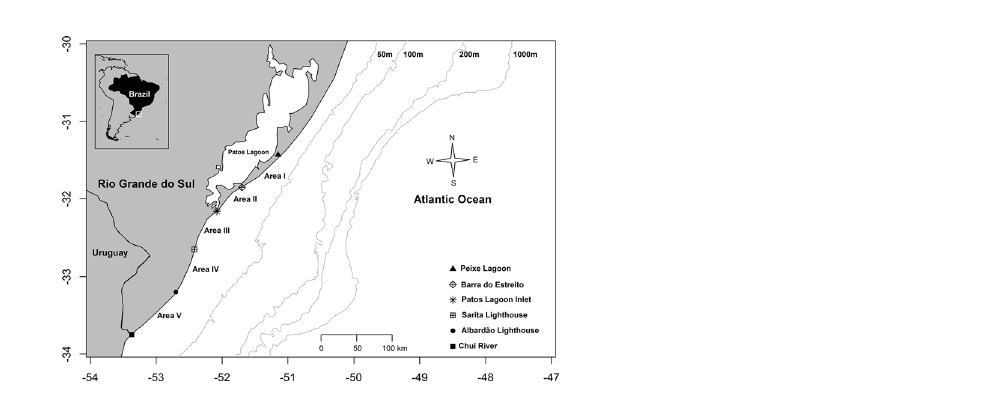
Fig 1. Study area. Area 1 = 87 km; Area 2 = 48 km; Area 3 = 63 km; Area 4 = 70; Area 5 = 87